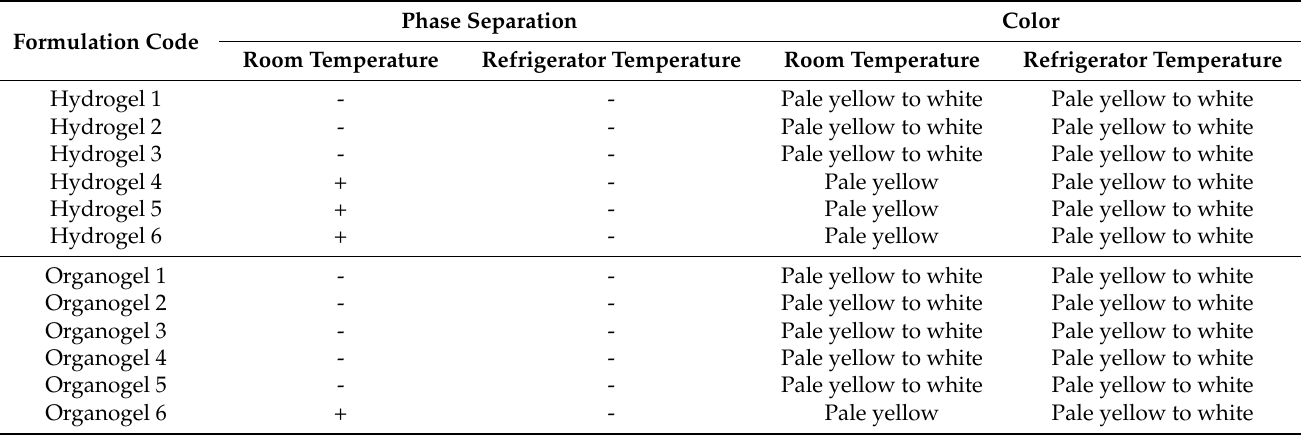
Table 3. The phase separations and changes in colors after 3 months of